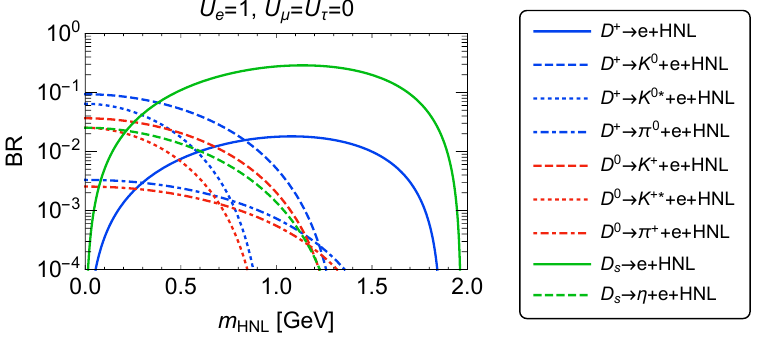
Figure 14 . The same plot as figure 13 but for charmed